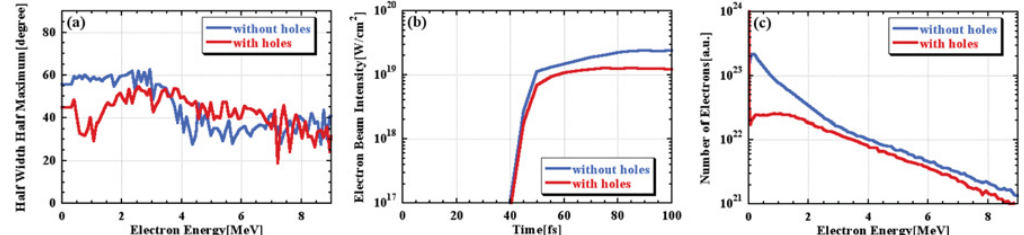
Figure 5. Quasi-static transverse magnetic field profiles at 50 fs for (a) density trough target (b) punched target.